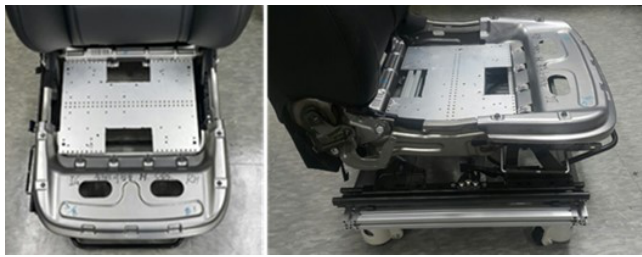
Figure 7. Testbed of SSA seats system. Front ( left ), Side ( right ).